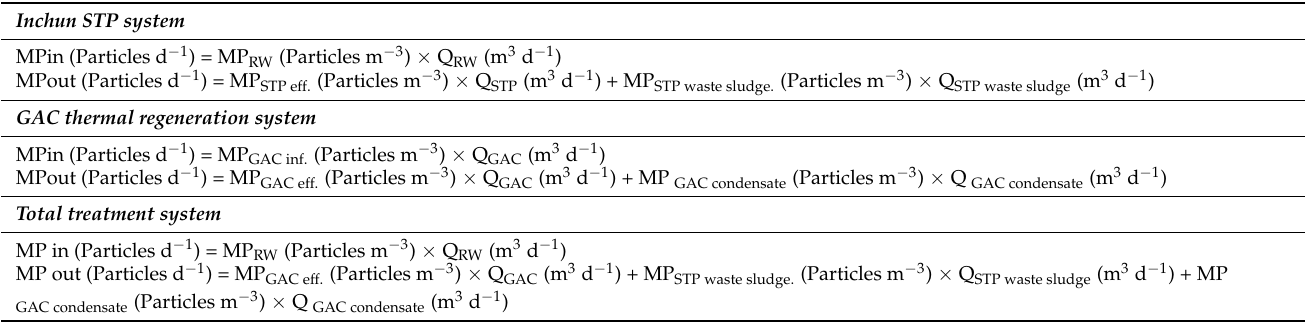
Table 2. Mass balance equations for MPs at suggested sewage treatment